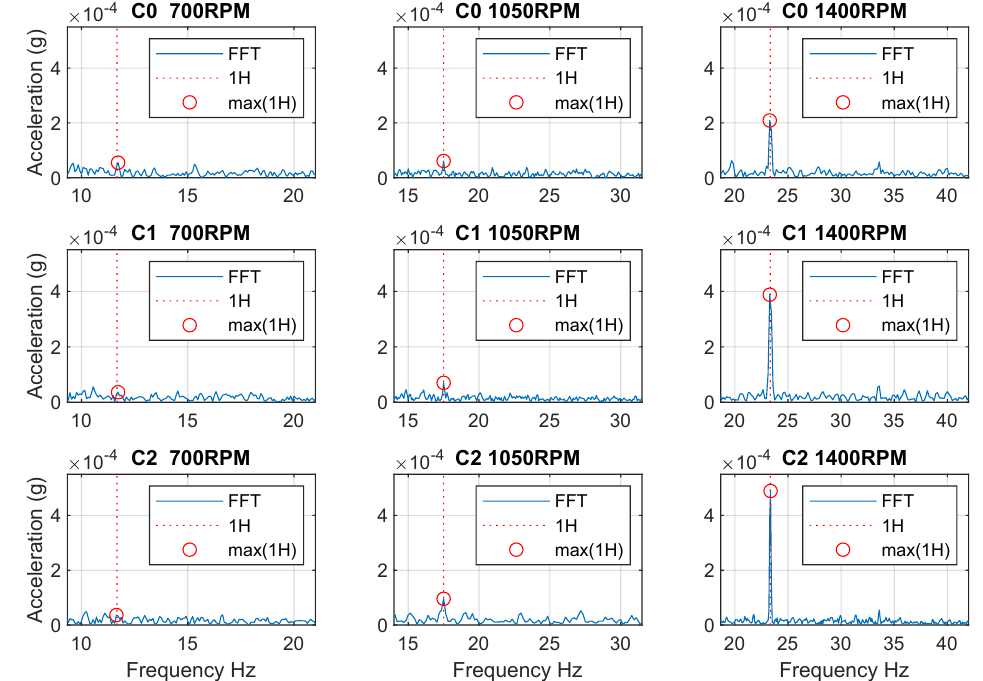
Figure 4. The first test of the effect of the fault in frequency domain (C0 − C2 are Class 0 − Class 2, 1H—first harmonic frequency, max(1H)—maximum of the first harmonic frequency).